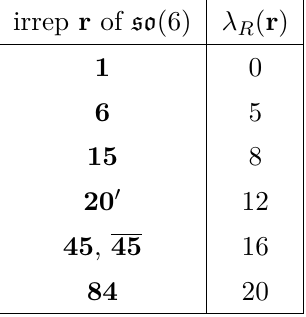
Table 4 . Eigenvalues of C R in the N = 6 case where the R-symmetry algebra is so (6) R